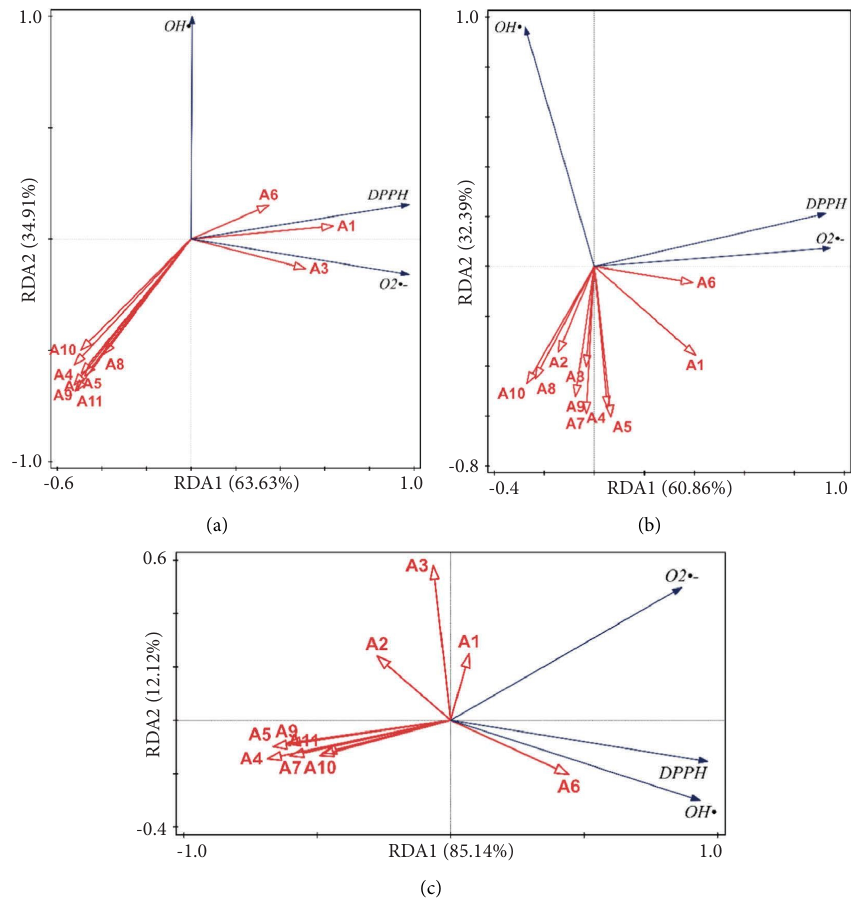
Figure 8: RDA between antioxidant ability and peaks: (a) HM of C. tubulosa . (b) WE of C. tubulosa . (c) HR of C. tubulosa . Te intersection angle represents the relevance between the scavenging ability of the free radicals and the peak. Te smaller the angle is, the more relevance there is with the peak of the